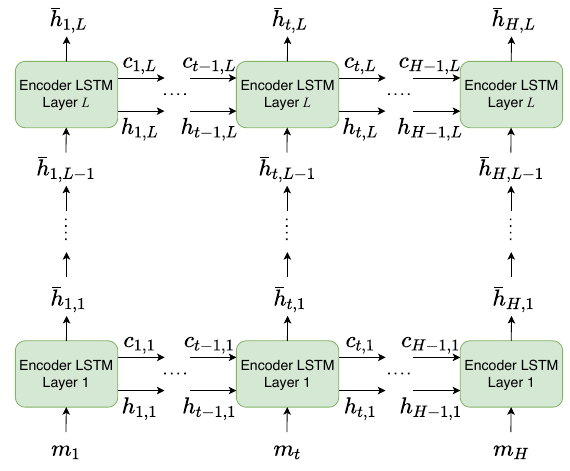
Figure 6. The neural architecture of the sub-network processing HRES data.